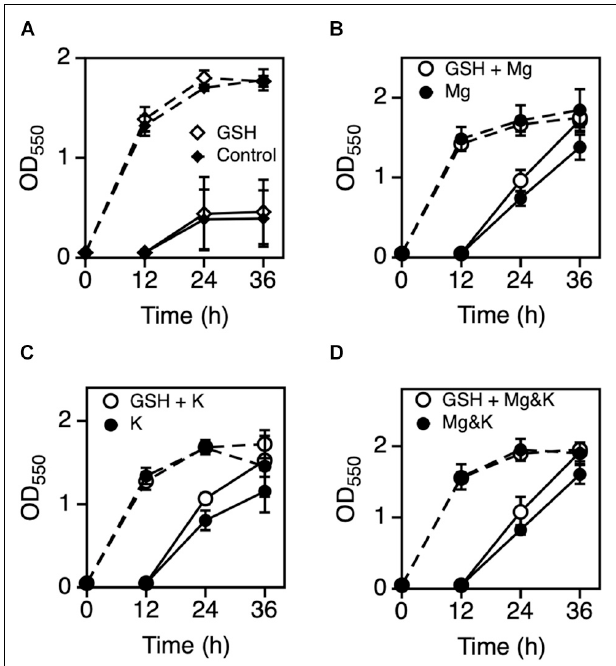
FIGURE 4 | Effect of GSH with Mg 2 + or K + on the growth of Zymomonas mobilis TIST R548. (A) Cells were grown in YPD medium with (open diamond) or without 0.5 mM GSH (control, closed diamond) at 39 ◦ C under a static condition. (B–D) Cells were grown in YPD medium containing 5 mM MgCl 2 (B) , 30 mM KCl (C) , or both 5 mM MgCl 2 and 30 mM KCl (D) with (open circle) or without 0.5 mM GSH (closed circle) at 39 ◦ C under a static condition. After 12 h, the first-stage culture (dotted lines) was inoculated into a fresh medium and subjected to subsequent (second stage) cultivation (solid lines) under the same medium condition. Additional and non-additional conditions of GSH are shown as open and closed circles, respectively. Values and error bars represent means and standard deviations, respectively, for triplicate cultures.